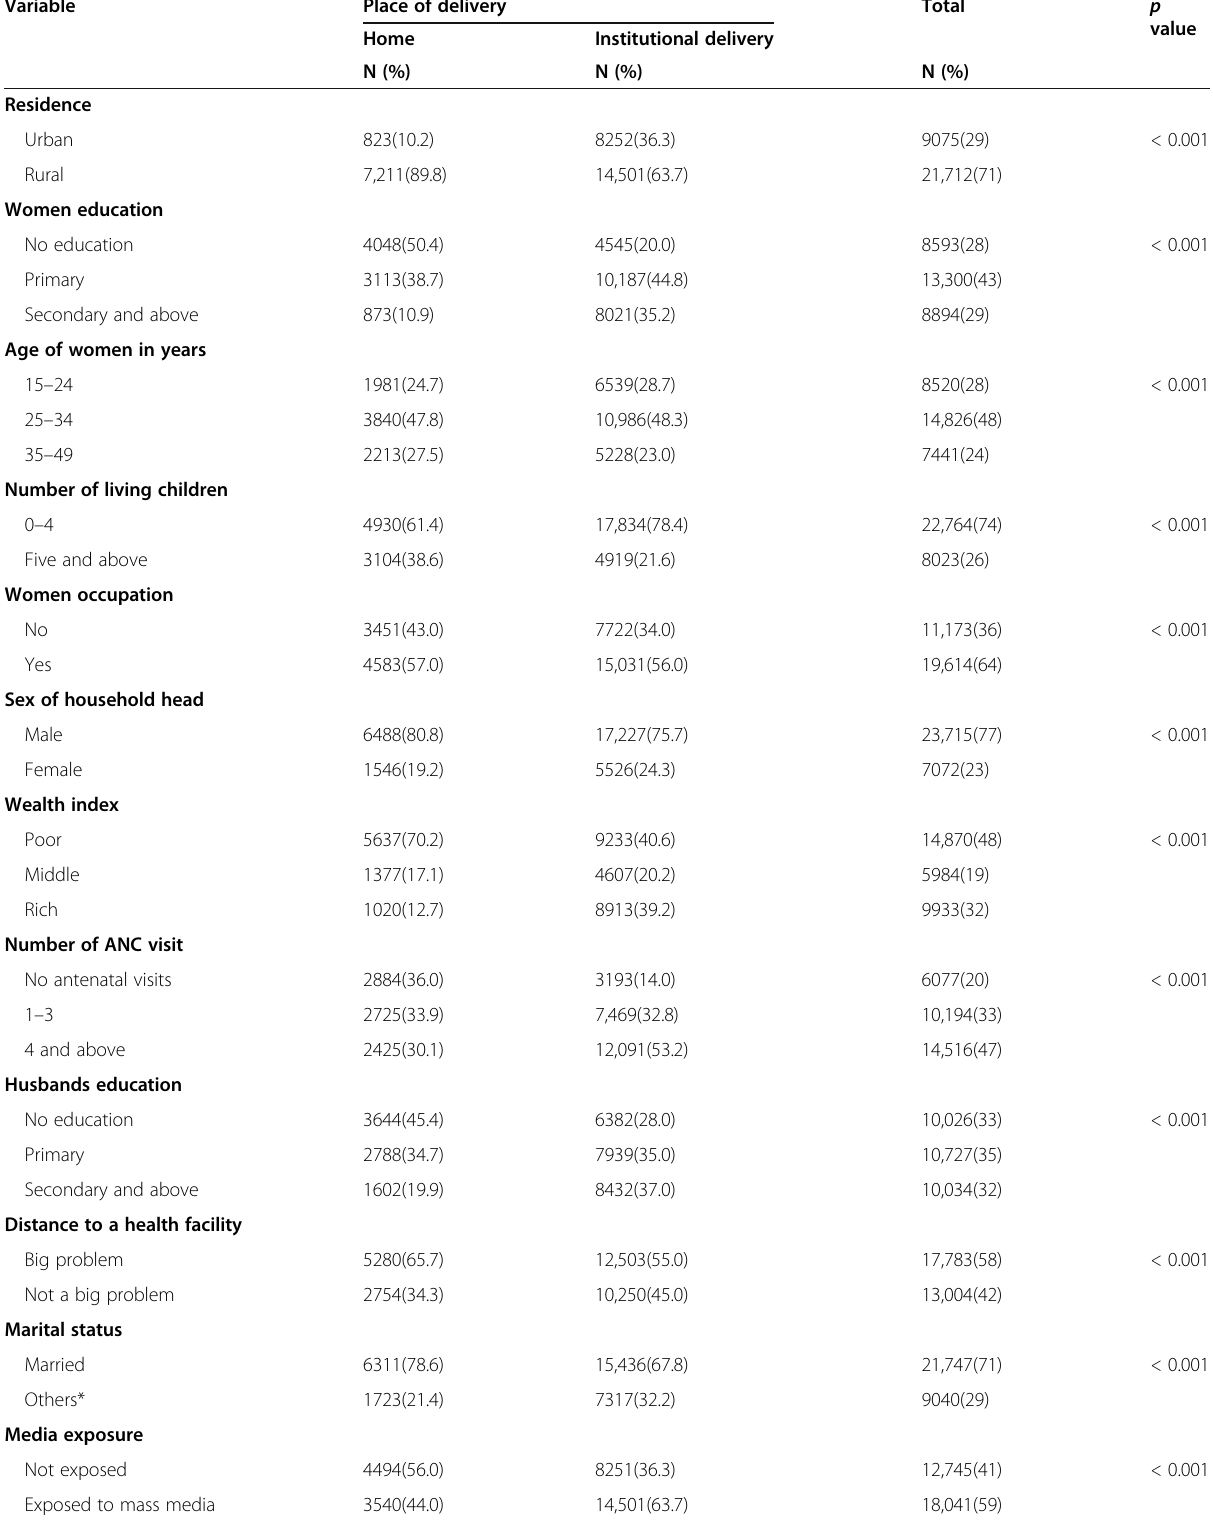
Table 2 Relationship between correlates and place of delivery in nine Sub-Saharan